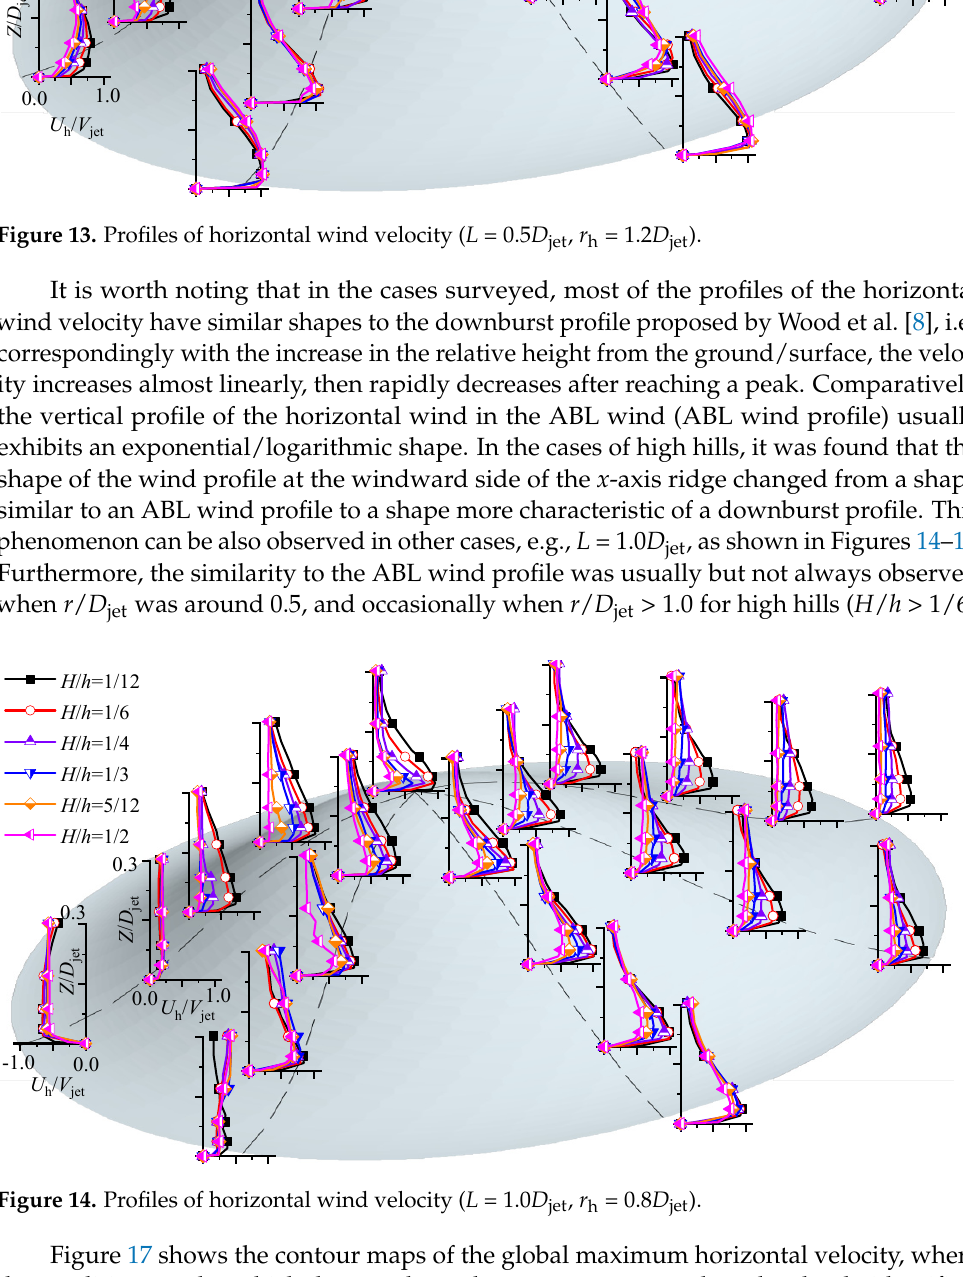
Figure 13. Profiles of horizontal wind velocity ( L = 0.5 D jet , r h = 1.2 D jet ).